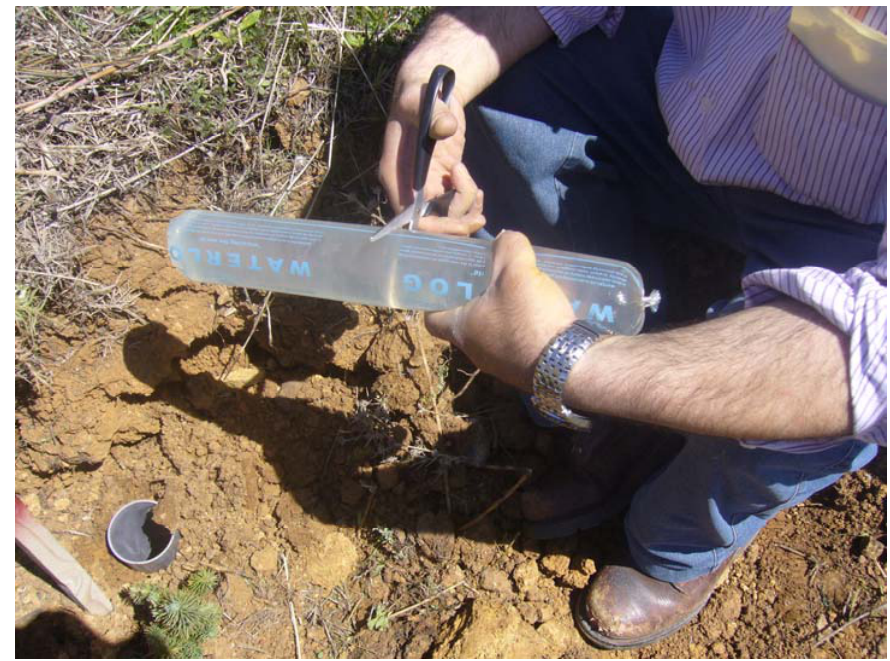
Figure 5. Each Non ‐ Rechargeable Solid Water (NRSW) bag was cut in half; contents from one half bag were emptied into each of two PVC pipes buried on each side of each seedling so gel contacted wet soil. Pipes were capped to keep out soil and mulch.